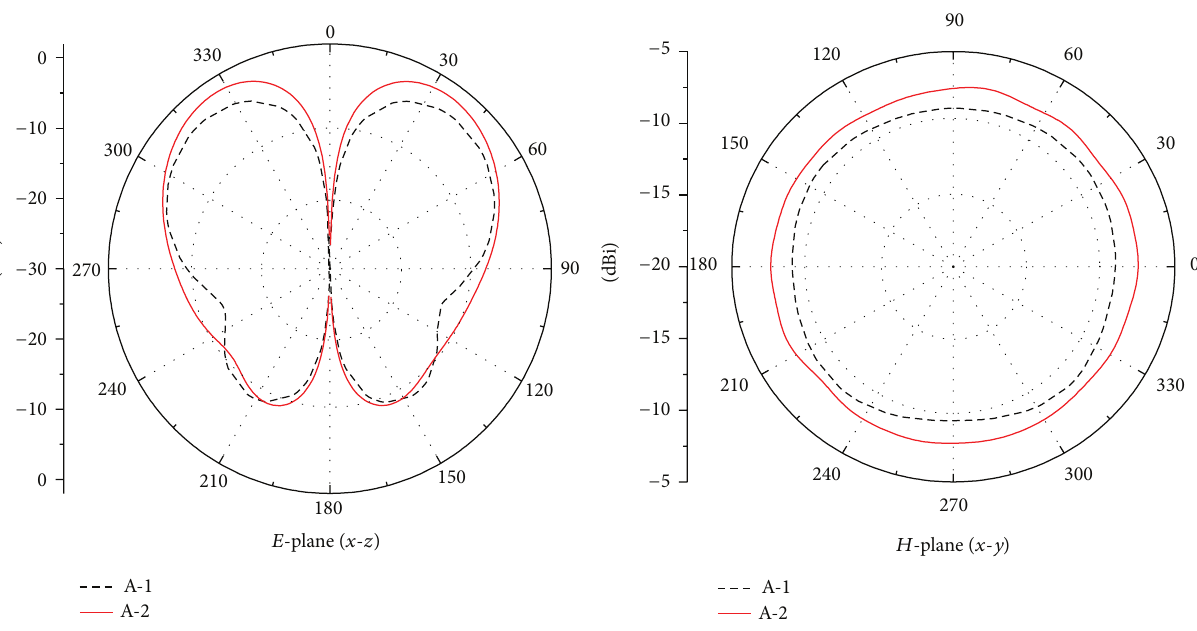
Figure 6: Simulated radiation patterns of A-1 and A-2 at 5.45